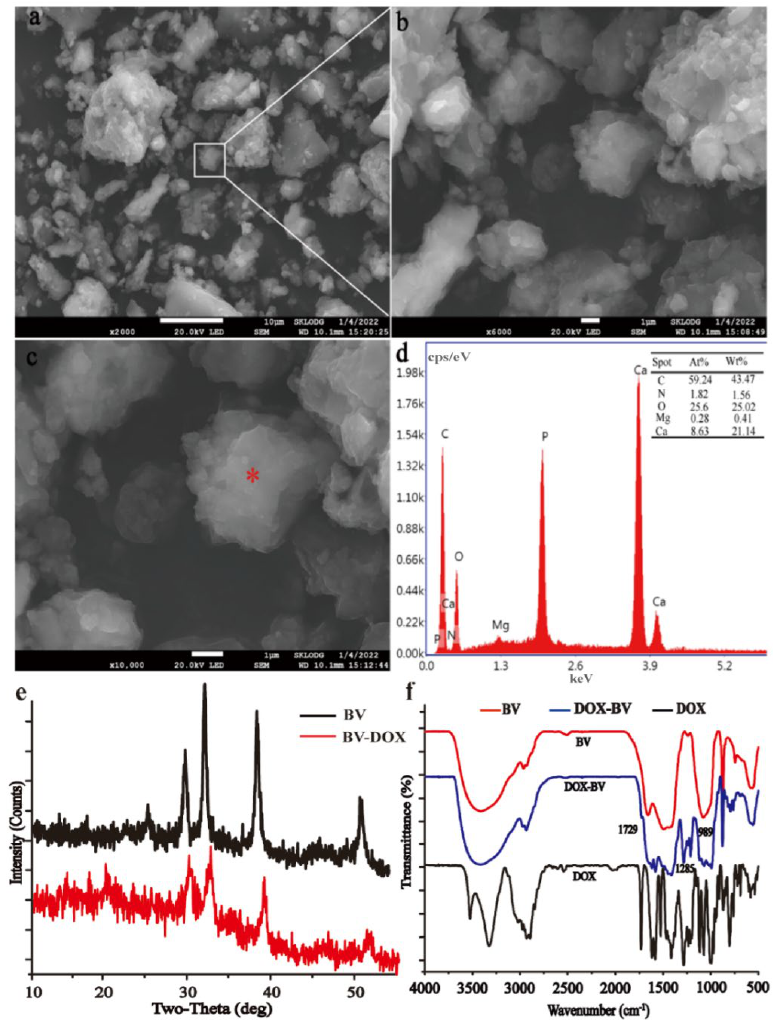
Figure 7. Characteristics and analysis of the BV-DOX mineral complex by using SEM ( a – c ), EDS ( d ), XRD ( e ), FTIR ( f